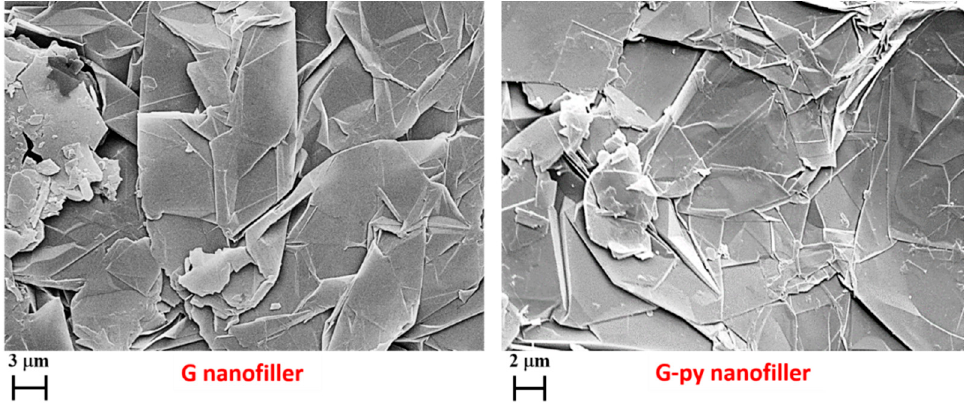
Figure 3. FESEM images of unfunctionalized G and functionalized G-py nanofillers.